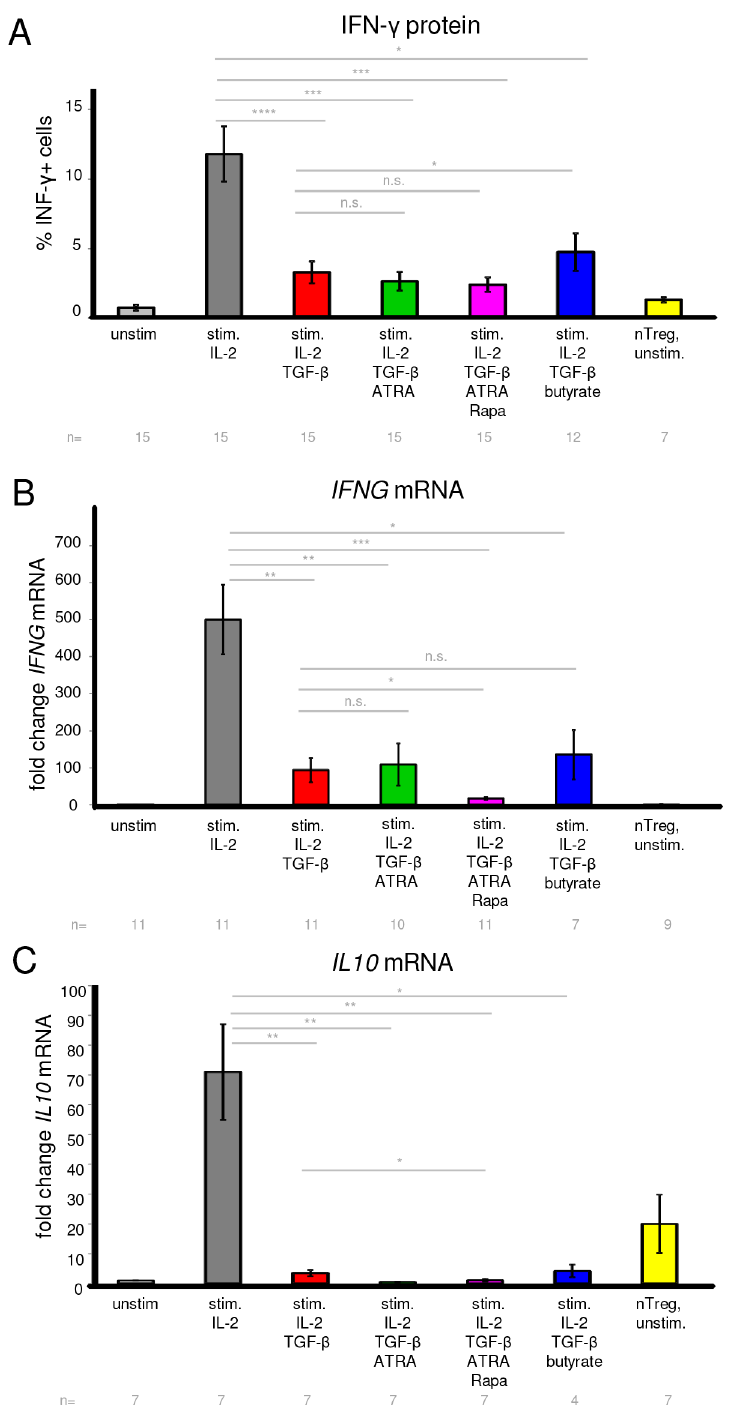
Fig 3. Cytokine production by human iTregs. (A) IFN- γ expression was measured by intracellular staining after 4 hours of PMA/ionomycin pulse on day 6 of culture under the indicated conditions, gated on live CD4+ cells. Shown are mean +/- SEM values for n = 7 to 15 donors (n numbers indicated below the bar chart). Significance was calculated with paired t test. (B) IFNG mRNA expression in naive T cells cultured 6 days under the indicated iTreg or control conditions. nTregs and unstimulated naive T cells were sampled on day 0. mRNA was quantified by Taqman assay, normalized to RPL13A expression. IFNG mRNA expression in unstimulated naive T cells from the corresponding donor was set to 1, and fold change of IFNG mRNA